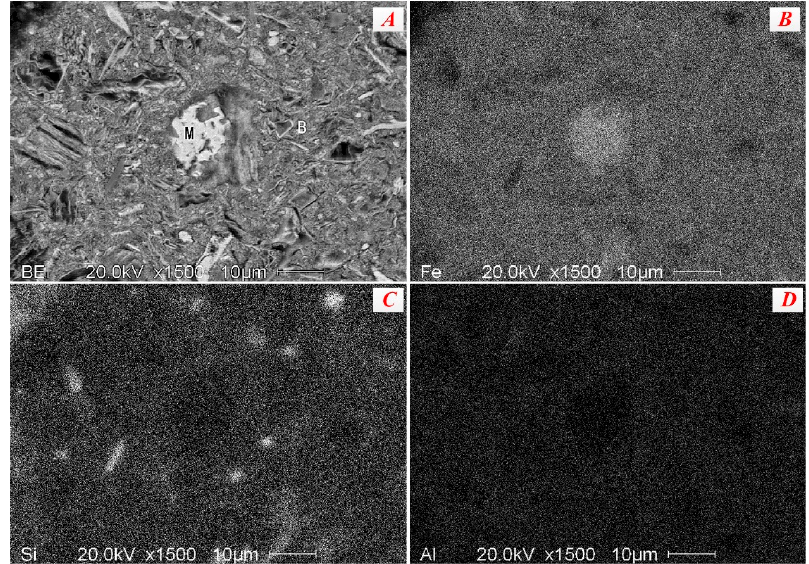
Figure 6. SEM back-scattered electron images of section minor magnetite as shown in Figure 4: M— magnetite, B—gangue minerals , ( A ) backscattering electronic image of fine magnetite particle; ( B ) surface scanning images of Fe; ( C ) surface scanning images of Si; ( D ) surface scanning images of Al.